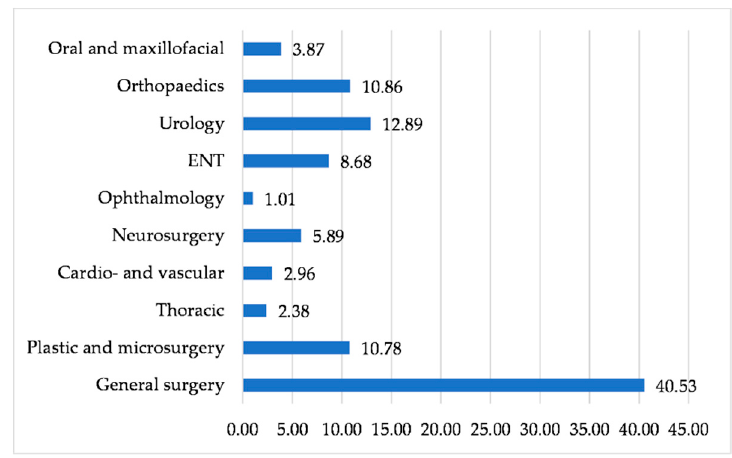
Figure 1. Antimicrobials prescribed by surgical departments expressed as DDDs percentages. Table 1. Antibiotics prescribed by